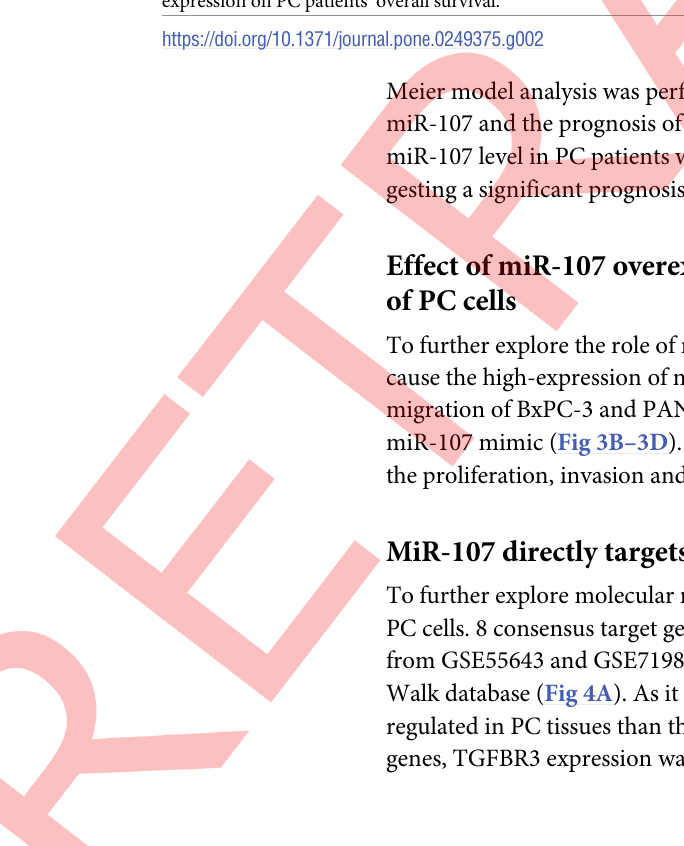
Fig 2. MiR-107 was elevated and associated with poor survival in PC. A, QRT-PCR analysis of the 19 dysregulated miRNAs in the HPDE, BxPC- 3 and PANC-1 cells. B & C & D Histograms exhibited the upregulation of miR-107 in PC tissues compared with normal tissues from GSE31568, GSE34052 and GSE41369 datasets, respectively. E, Kaplan–Meier curve and log-rank test were implemented to test the effects of miR-107 expression on PC patients’ overall